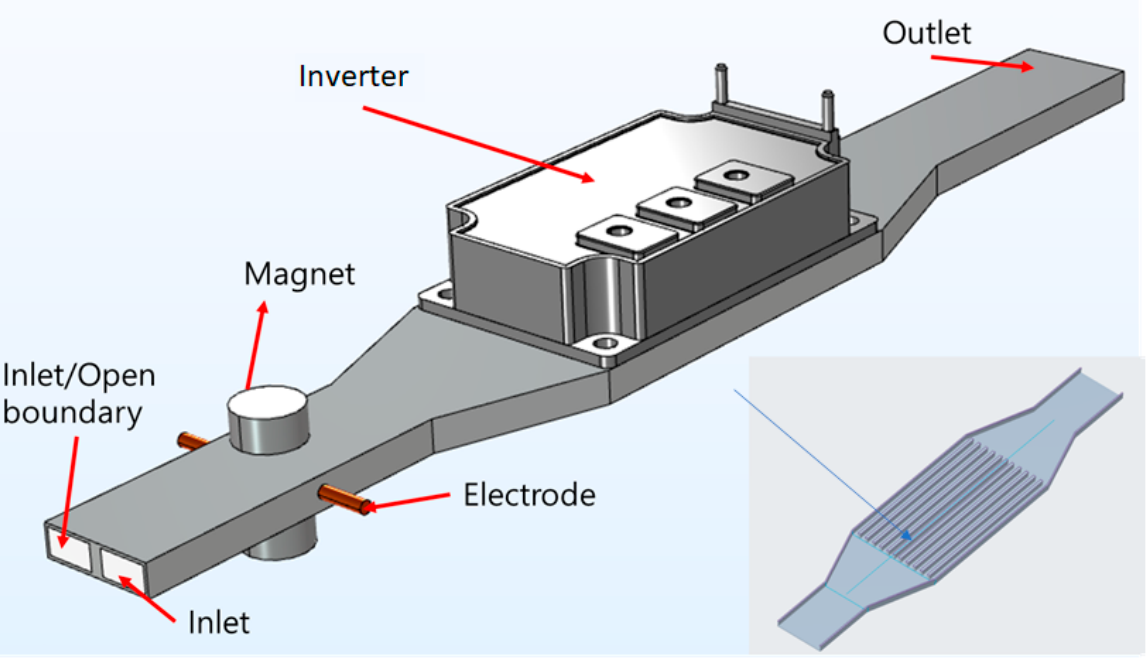
Figure 1. Computational domain of MHD pump-based cooling for traction inverter.